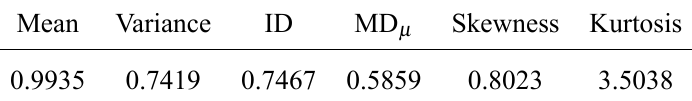
Summary Statistics of